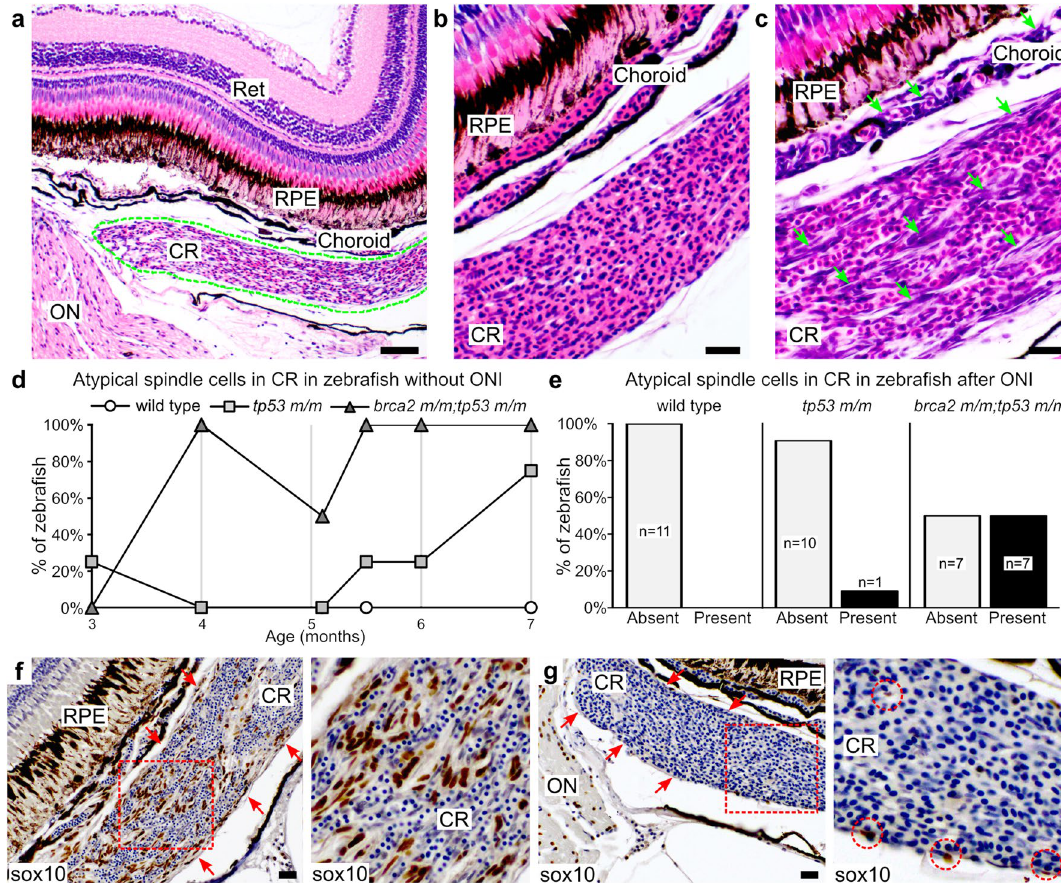
Figure 2. Atypical spindle cells accumulate in the choroid rete of brca2 m/m;tp53 m/m zebrafish. ( a ) The choroid rete (outlined in green) is a vascular plexus located subjacent to the choroid. ( b ) Normal choroid rete. ( c ) Choriod rete containing numerous atypical spindle cells (green arrows). ( d ) Numbers of zebrafish that developed atypical spindle cells in the choroid rete over time (n = 4 per genotype at each time point analyzed). ( e ) Numbers of zebrafish that received optic nerve injury and developed atypical spindle cells in the choroid rete. ( f ) Atypical spindle cells in the choroid rete are sox10-positive (brown chromogen). Red arrows delineate margins of choroid rete. Area boxed in red is shown at higher magnification to the right. ( g ) Small numbers of sox10-positive cells (brown chromogen) are present in the normal choroid rete. Red arrows delineate margins of choroid rete. Area boxed in red is shown at higher magnification to the right. Red circles identify sox10-positive cells. Ret, retina; RPE, retinal pigmented epithelium; CR, choroid rete; ON, optic nerve. Scale bar = 50 µm (panel a); 20 µm (panels b, c, f,